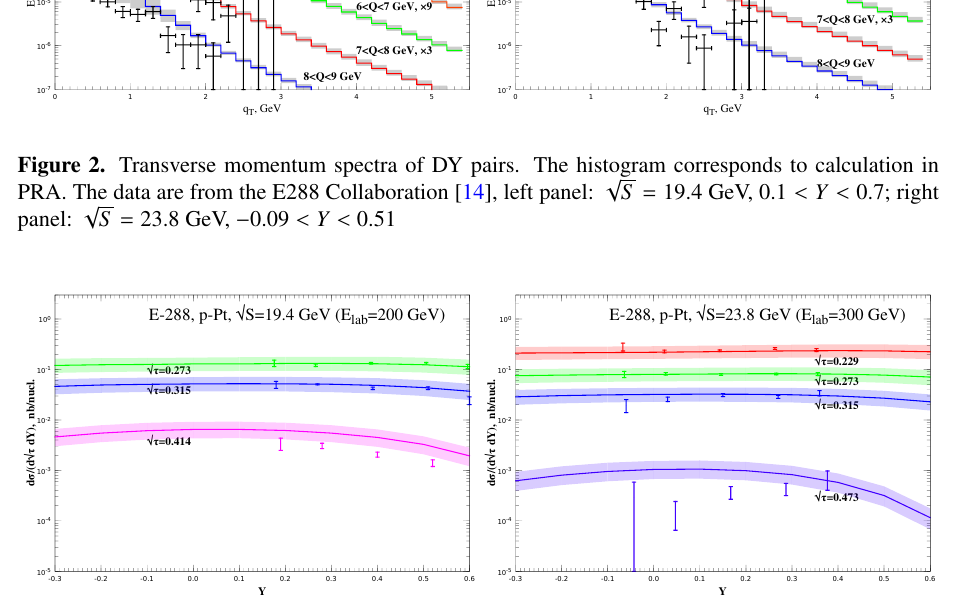
√ √ S = 19 . 4 GeV; right panel: S = 23 . 8